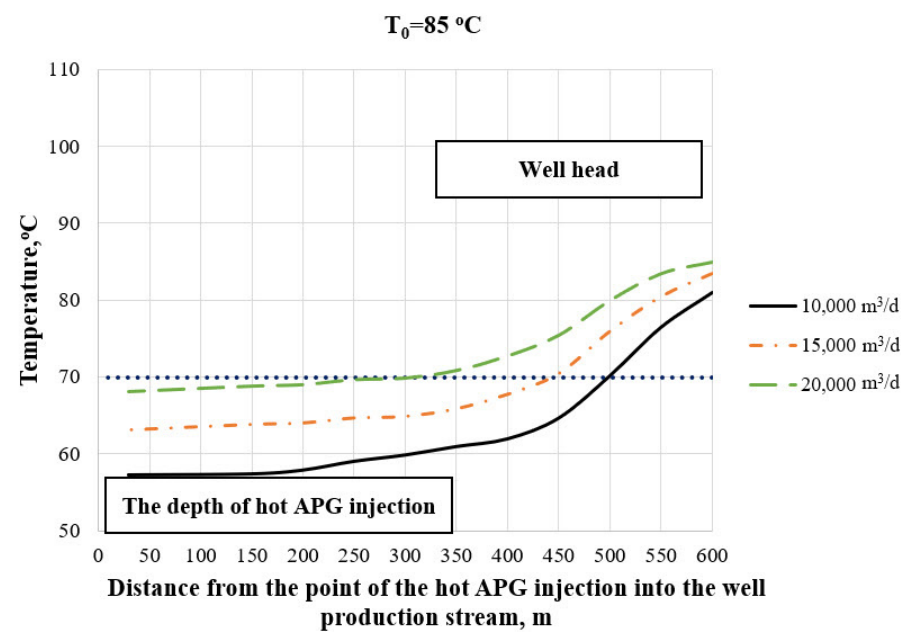
Figure 11. Annulus hot APG temperature profile, inlet T 0 = 85 °C.